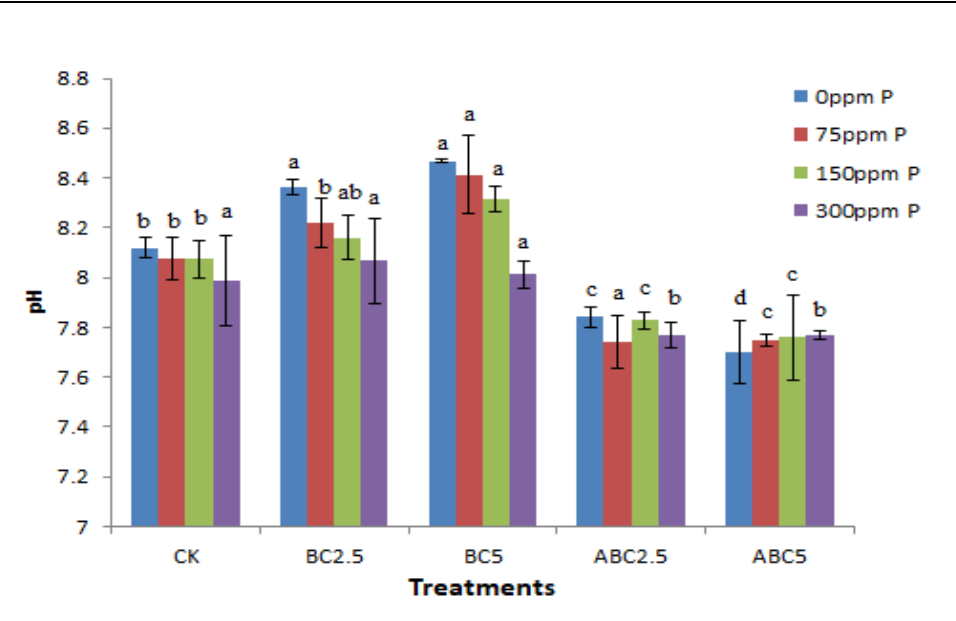
Figure 3. Effects of BC and ABC applied at different rates with different P fertilizer application rates on soil pH. Means with different letters within each fertilizer rate across each treatment indicate significant differences according to the least significant difference (LSD) test at p < 0.05. CK = Control, BC2.5 = Biochar added at 2.5% w / w , BC5 = Biochar added at 5% w / w , ABC2.5 = Acidified biochar added at 2.5% w / w , and ABC5 = Acidified biochar added at 5% w / w .